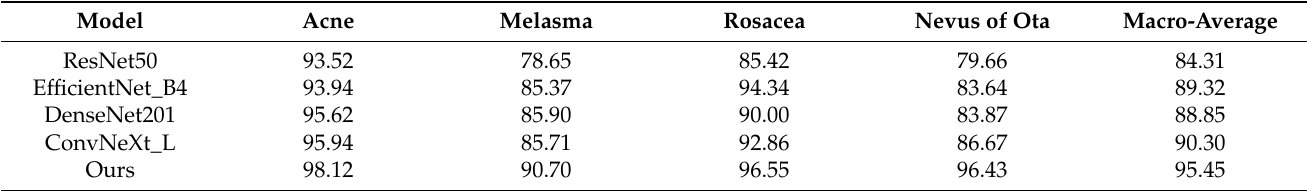
Table 2. The precision of each model on our private dataset; the unit is %.